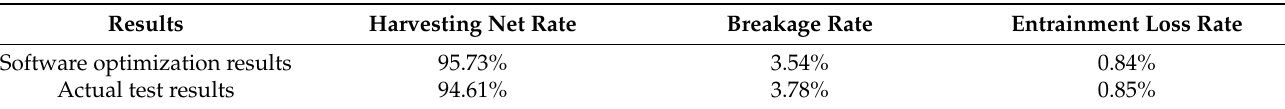
Figure 8. Test process. Table 5. Optimization results.